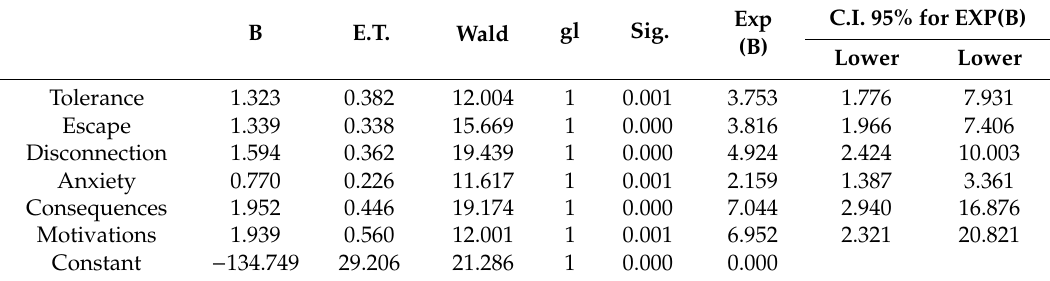
Table 10. Binary logistic regression of the self-perception on the problematic smartphone use a of university students between 21 to 23 years of age with respect to the MPPUSA.